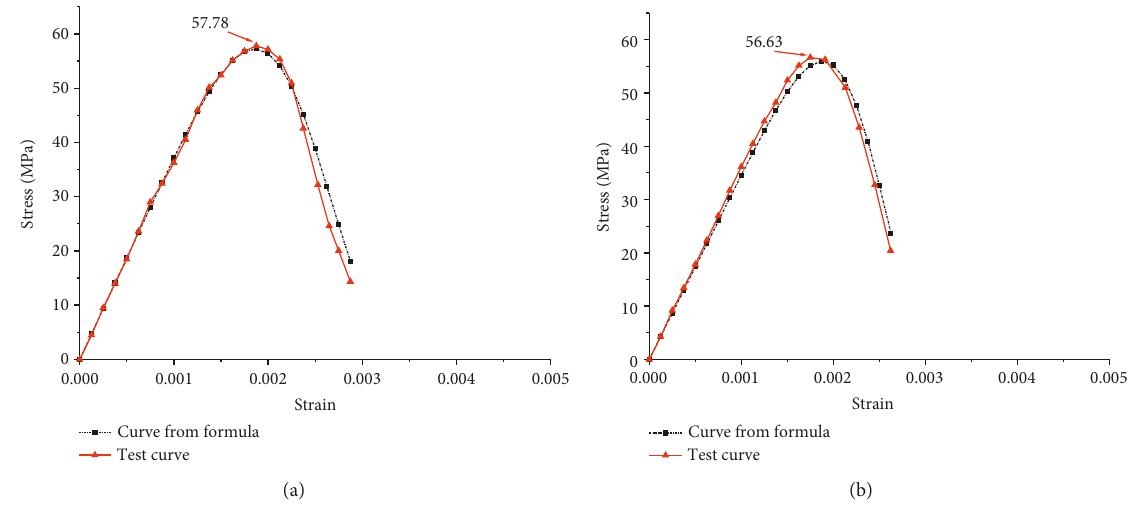
Figure 6: Comparison of test curves and curve from formula of C60 concrete. (a) Internal environment. (b) External